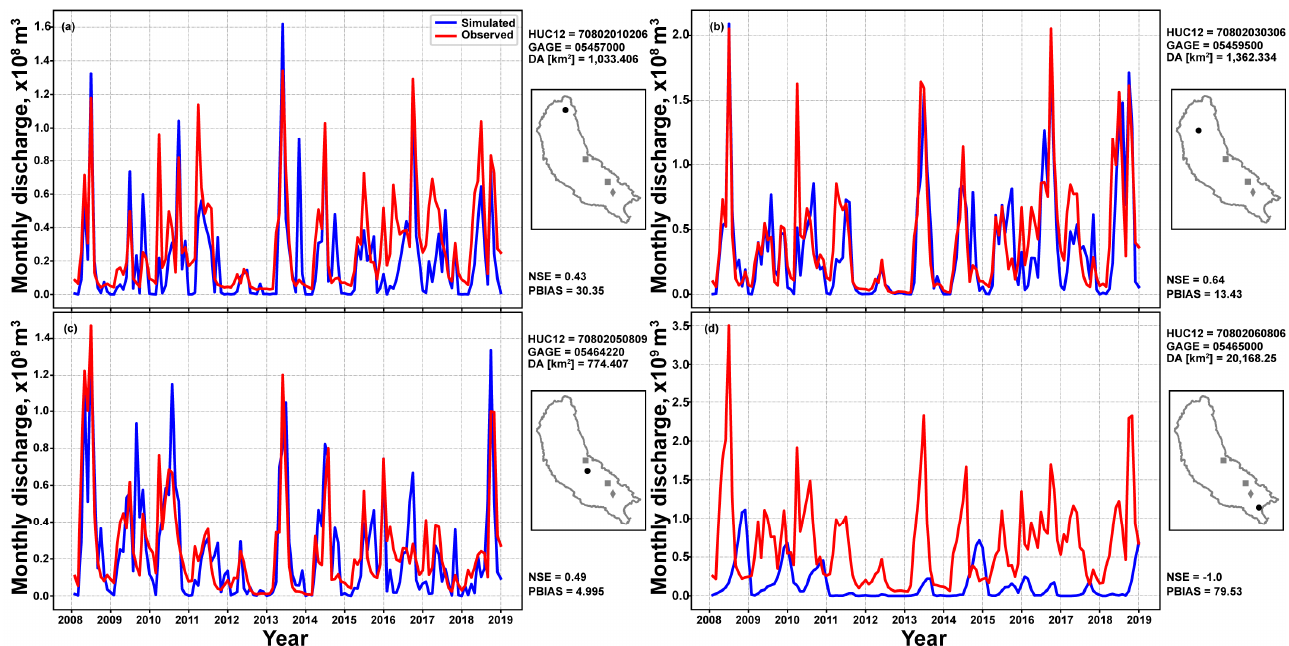
Figure 12. Comparison between observed and simulated surface flow. Black circles indicate location of stream gage, gray rectangles urban areas, and gray diamond a large dam. Simulated datasets do not include base flow. Differences between simulations of agricultural watersheds ( a – c ) with larger and more complex systems ( d ) demonstrates the challenges involving simulating controlled systems.